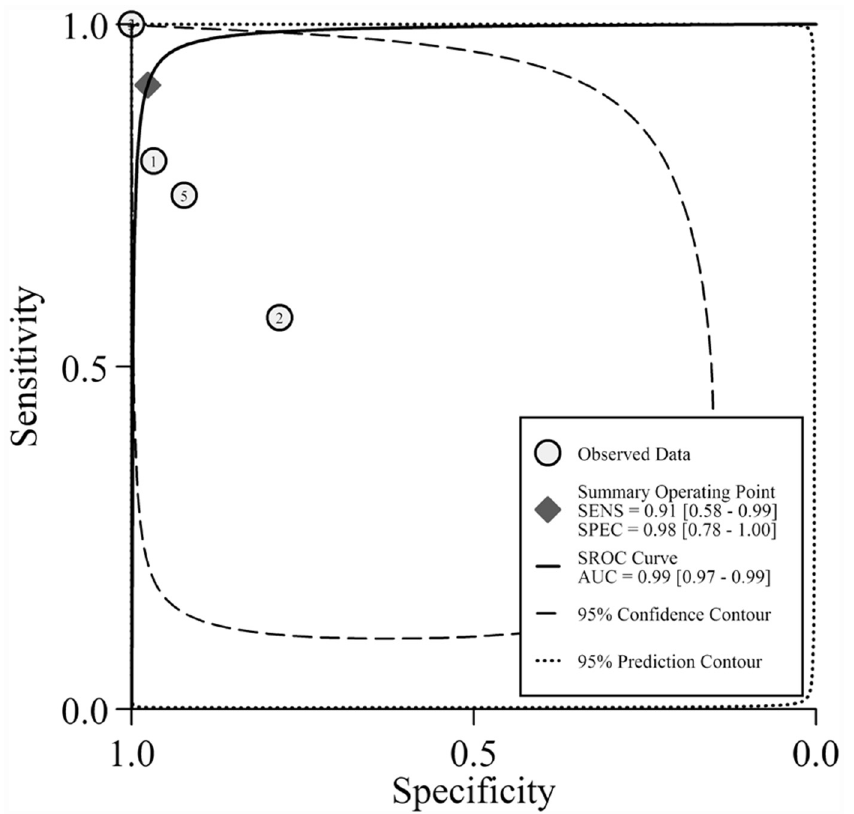
Fig 5. SROC curve with confidence and prediction regions around overall operating sensitivity and specificity point of MBC